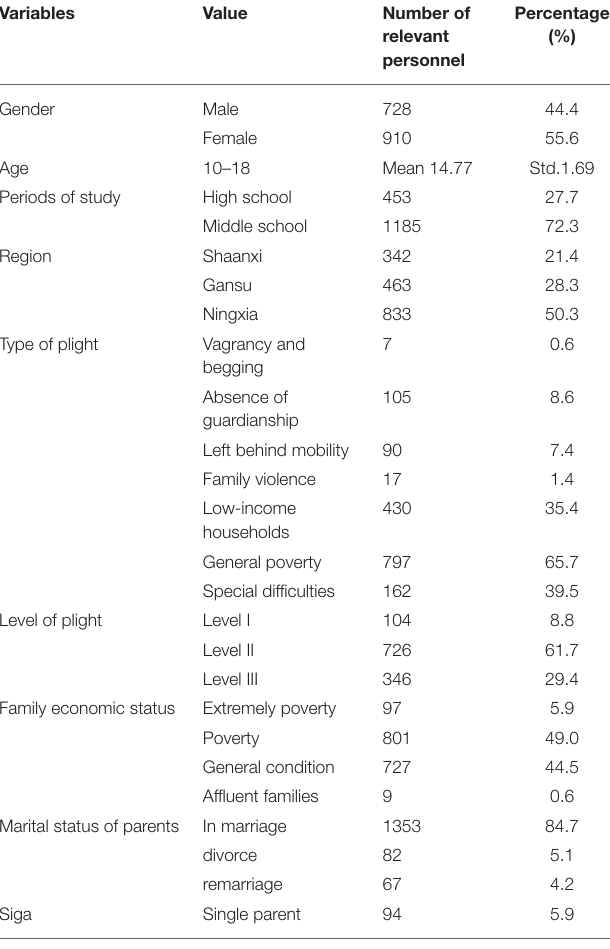
TABLE 4 | Situation of respondents ( n